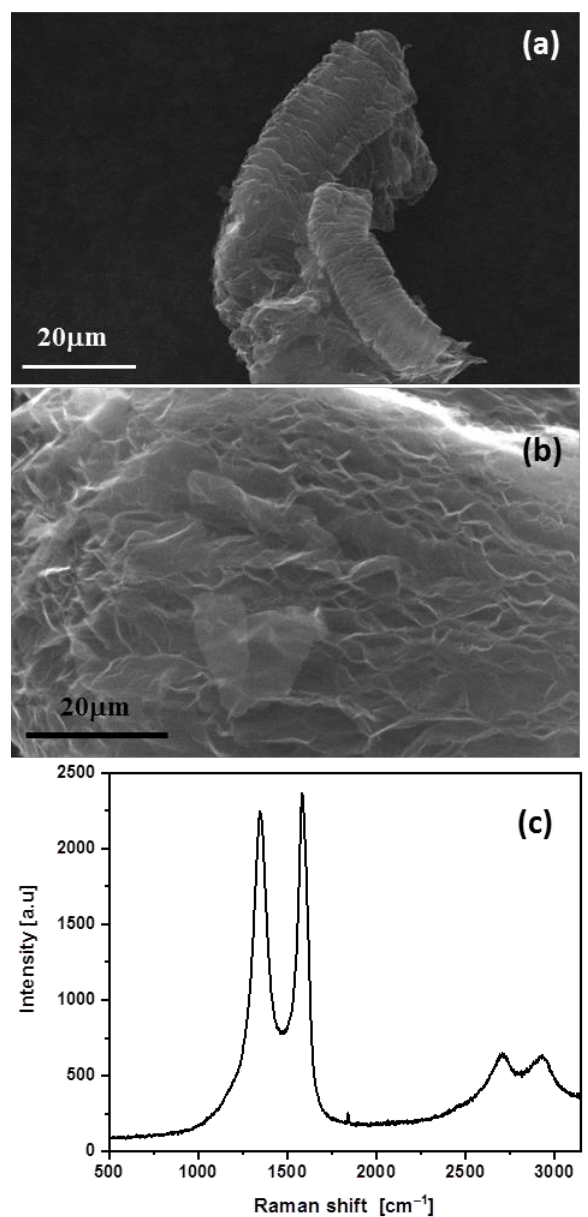
Figure 1. SEM images at different magnifications ( a , b ) and Raman spectrum ( c ) of the G employed for PET/G nanocomposite fibers.